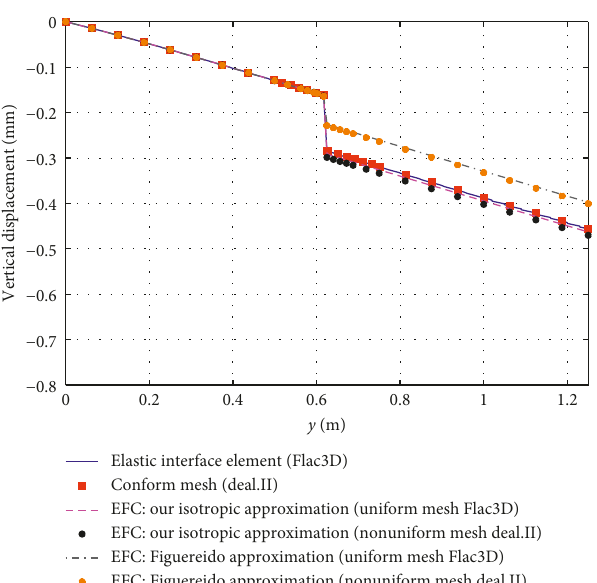
Figure 6: Vertical displacement following the vertical cut at the middle of medium intersected by an oriented fracture ( θ � 45 ° ). Comparison of the results conducted with the interface element model by Flac3D, conformed mesh model by deal.II, uniform mesh model by Flac3D, and nonuniform mesh model using the local refinement technique with hanging nodes by